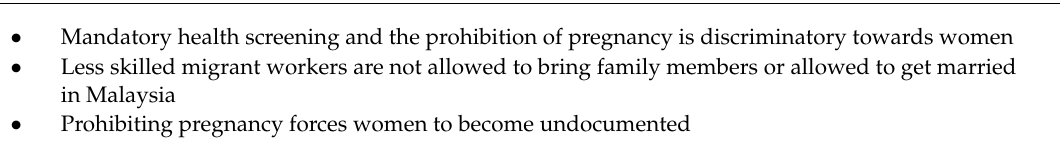
Table 2. Summary of major study